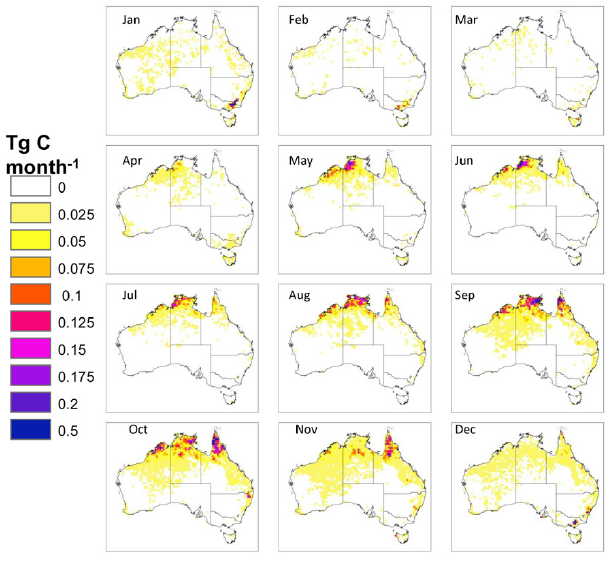
Fig. 11. Ensemble average GFED CO 2 -C gross fire emissions 0.5 ◦ × 0 . 5 ◦ grid cell (1997–2009) by month. the Australian coastline is estimated to be 2.3 ± 1 TgC yr − 1 .